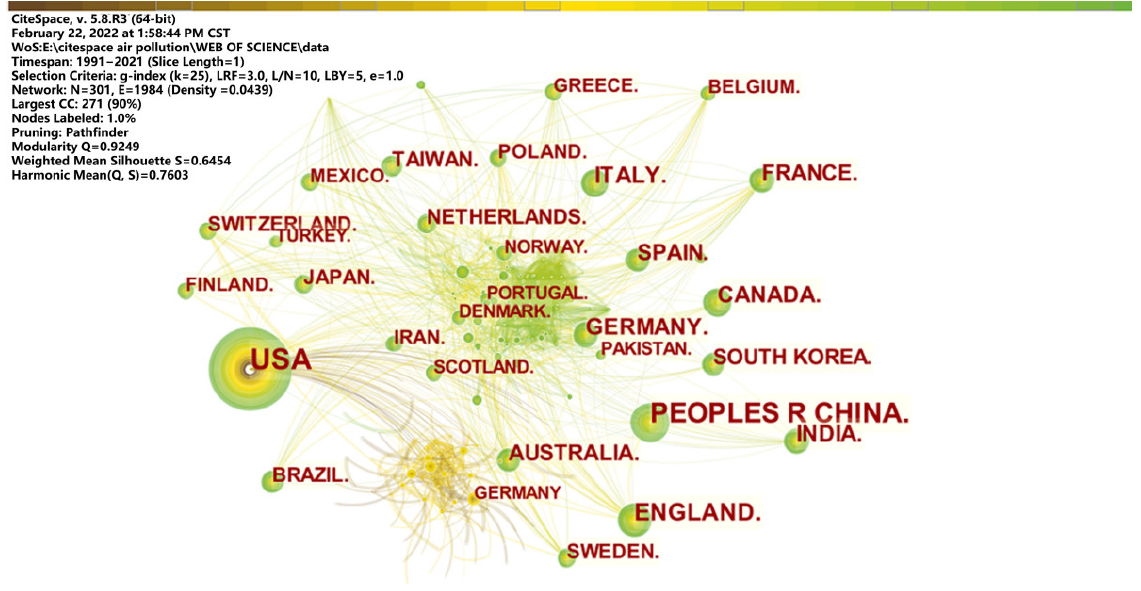
Figure 7. Co-occurrence knowledge mapping of the issuing countries.